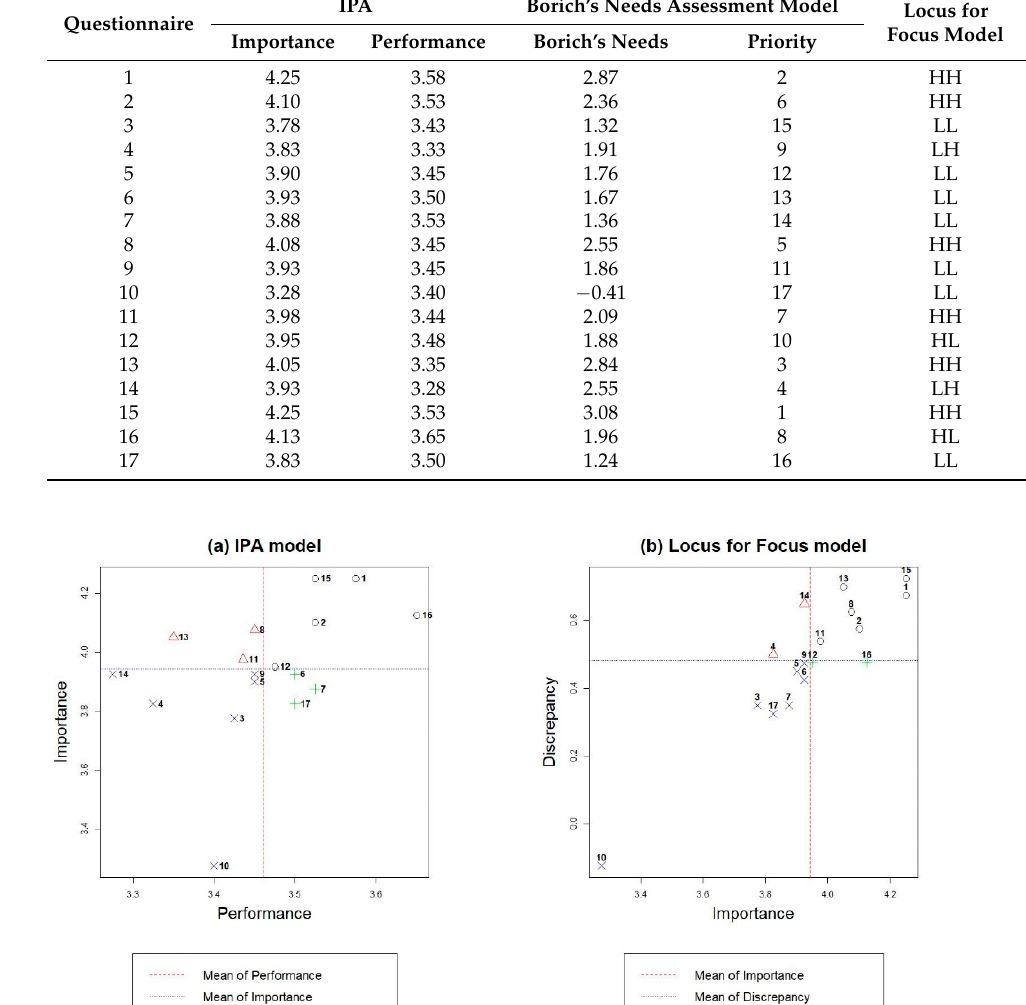
Table 5. IPA, Borich’s needs assessment, and the locus for focus model for Costa Concordia Case 2 (from the IMO long-term action plan).